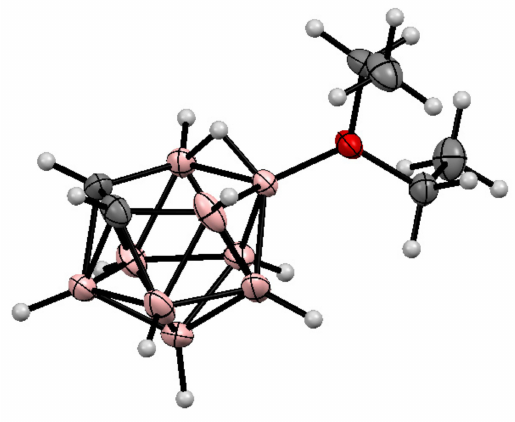
Figure 2. The molecular structure of 10-Et 2 O-7,8-C 2 B 9 H 11 .